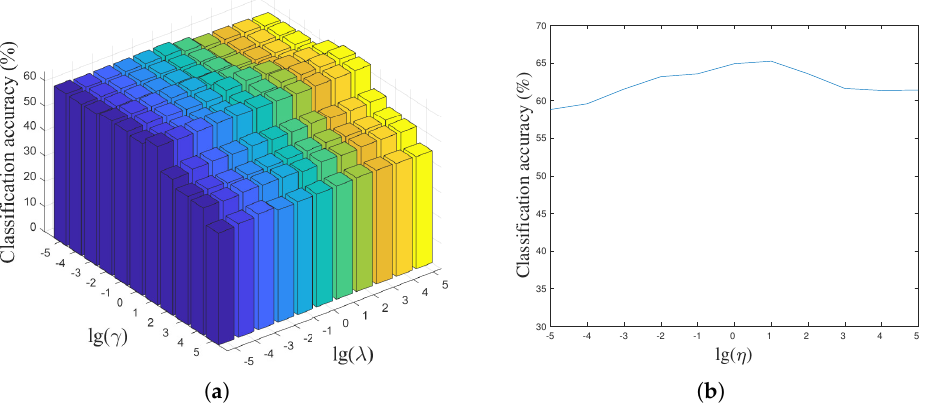
Figure 7. The classification accuracy versus parameters λ , γ and η on the Caltech 101 object dataset; ( a ) parameter η is fixed; ( b ) parameters λ and γ are fixed.